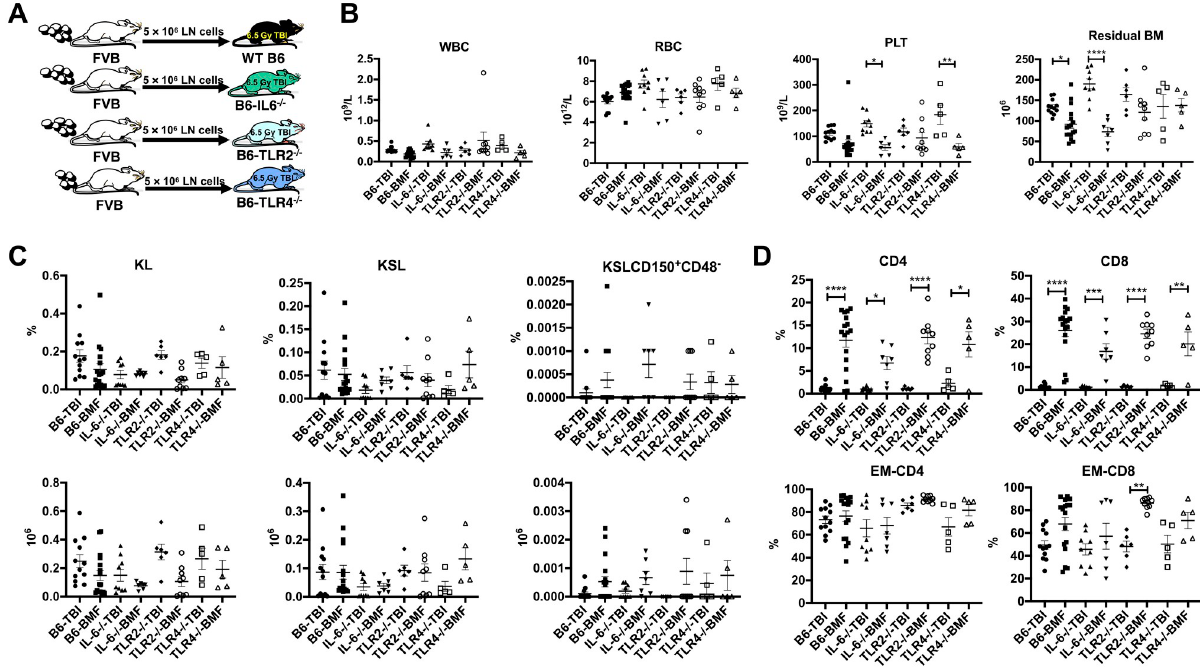
Fig 3. Maintained susceptibility to immune-mediated BMF following germline deletion of IL-6, TLR2 and TLR4. A. B6, IL-6 -/- , TLR2 -/- and TLR4 -/- mice were pre-irradiated with 6.5 Gy TBI 4–6 hours early without (TBI controls, N = 12, 9, 6, 5) or with the infusion of at 5 × 10 6 LN cells/ recipient from gender-matched FVB donors (BMF, N = 17, 7, 9, 5). Recipient mice were bled and analyzed at day 9 following LN cell infusion. B. WBC, RBCs, platelets, and residual BM cells (BM cells excluding CD4 and CD8 T cells) in B6, IL-6 -/- , TLR2 -/- , and TLR4 -/- recipient mice that received LN infusion from FVB donor mice. C. Proportions of BM CD4 + , CD8 + , EM-CD4 + , and EM-CD8 + T cells in the BM of BMF-IL-6 -/- , BMF-B6, BMF-TLR2 -/- , and BMF-TLR4 -/- mice relative to their TBI controls. D. Proportion and total number of KL (Kit + Lin - ), KSL (Kit + Sca-1 + Lin - ), and KSLCD150 + CD48 - hematopoietic stem and progenitor cells in the BM of B6, IL-6 -/- , TLR2 -/- , and TLR4 -/- recipient mice that received LN infusion from FVB donor mice. � , P < .05; �� , P < .01; ���� , P < .0001.